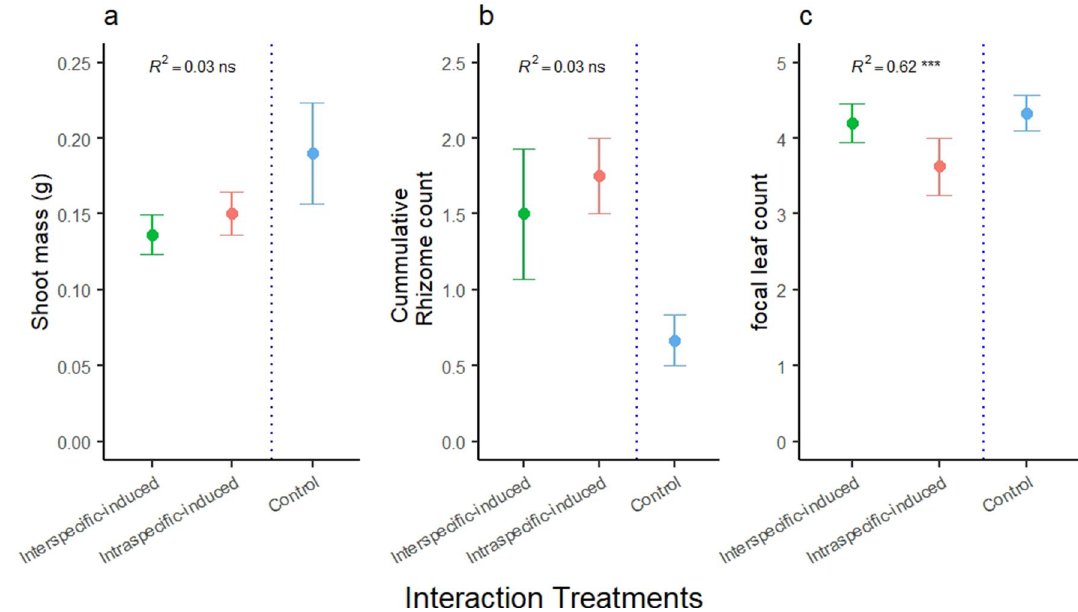
Figure 3. Mean ± standard error of Pascopyrum smithii plants induced by intraspecific and interspecific neighbors for ( a ) focal plant shoot mass, ( b ) cumulative rhizomes per pot, and ( c ) focal plant number of leaves. Significance levels are denoted by ns P > 0.5; * P ≤ 0.05; ** P ≤ 0.01; *** P ≤ 0.001.